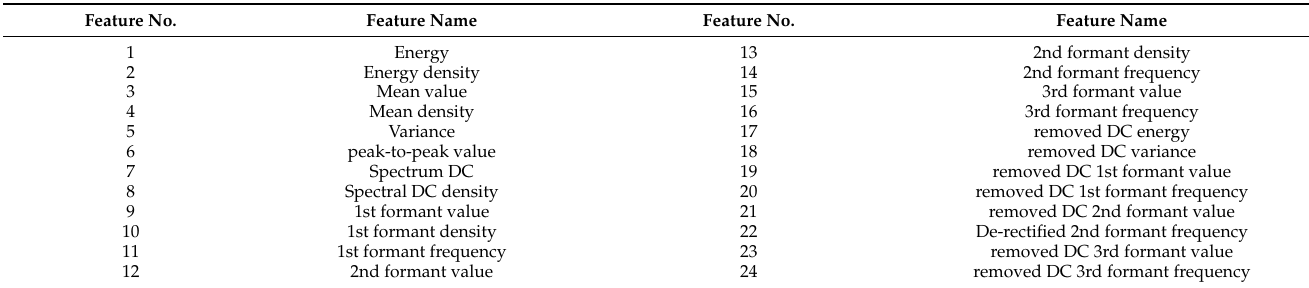
Table 7. Features of plant stems and feature